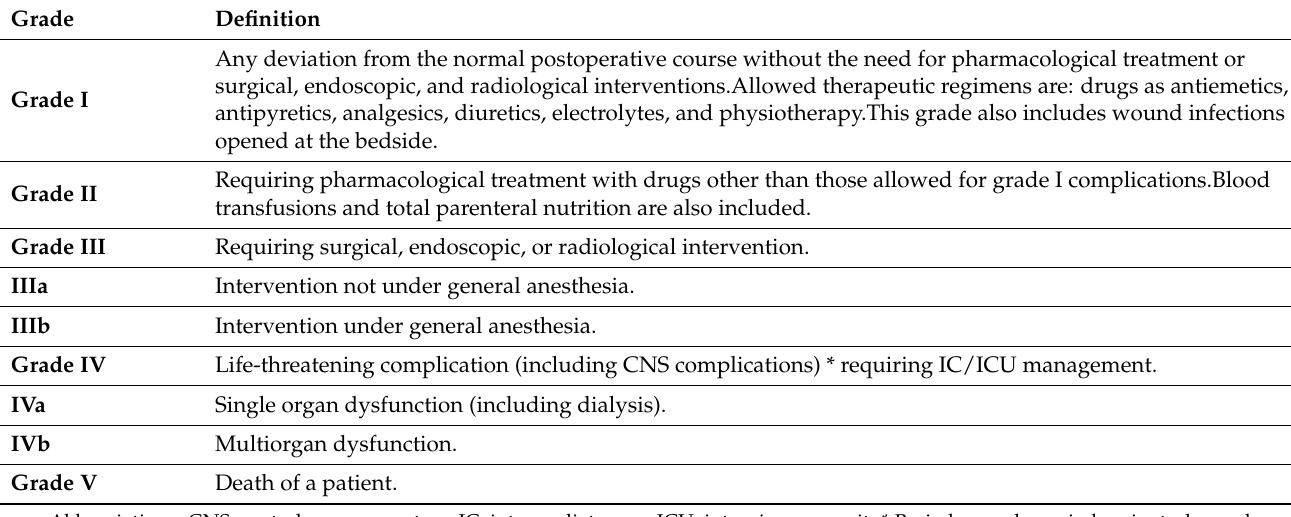
Table 2. Clavien–Dindo classification of surgical